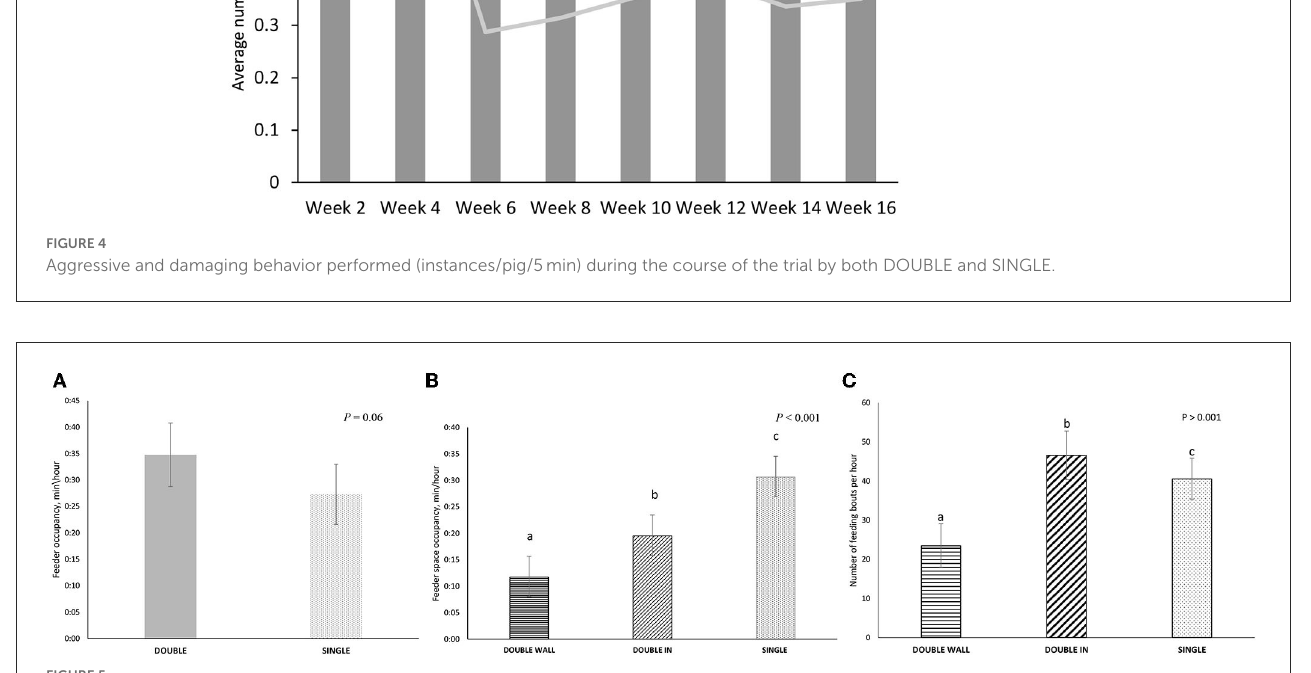
FIGURE5 Feeding-related behavior in two treatments: (1) SINGLE, where pigs of twelve pigs had access to a single space feeder, and (2) DOUBLE where pens of 12 pigs had access to a double spaced feeder (i.e., one space per six pigs). Feed spaces in DOUBLE were classified as WALL (next to the front wall of the pen) or IN (adjacent to WALL, but on the inner side of the pen. Behavior was recorded continuously by video in each pen on four occasions for 1h during the production cycle (i.e., 48h of observation per treatment in total). (A) Total occupancy at the feeder in DOUBLE and SINGLE (min/h). (B) Total occupancy per feeder spaces (min/h) in DOUBLE WALL, DOUBLE IN, and SINGLE. (C) The total number of feeding bouts per hour in DOUBLE WALL, DOUBLE IN, and SINGLE. The different letters represent significance